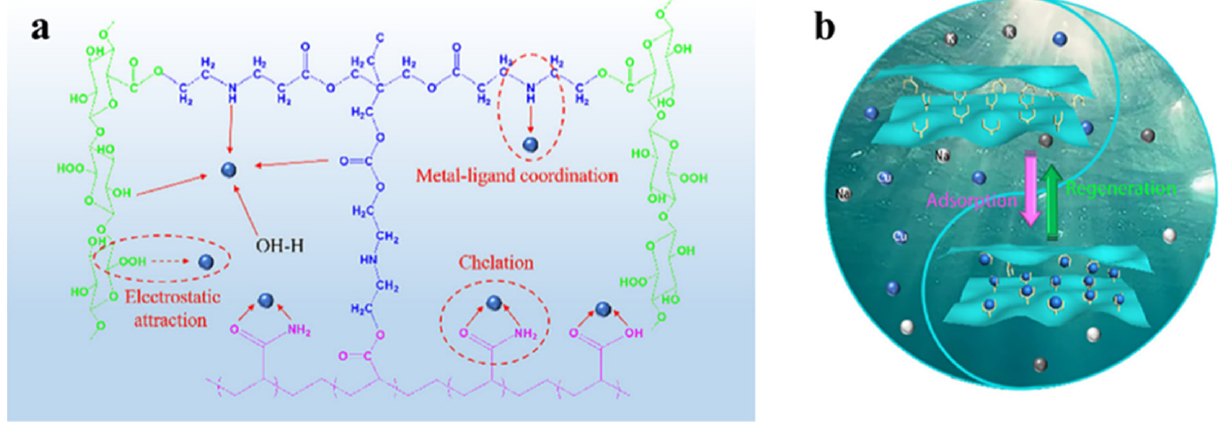
Figure 5. ( a ) Adsorption mechanism of cellulose nanofiber/polyacrylamide composite aerogel. ( b ) Graphical illustration of the adsorption-regeneration of Cu 2+ by cellulose nanofiber/ polyacrylamide composite aerogel [117] .